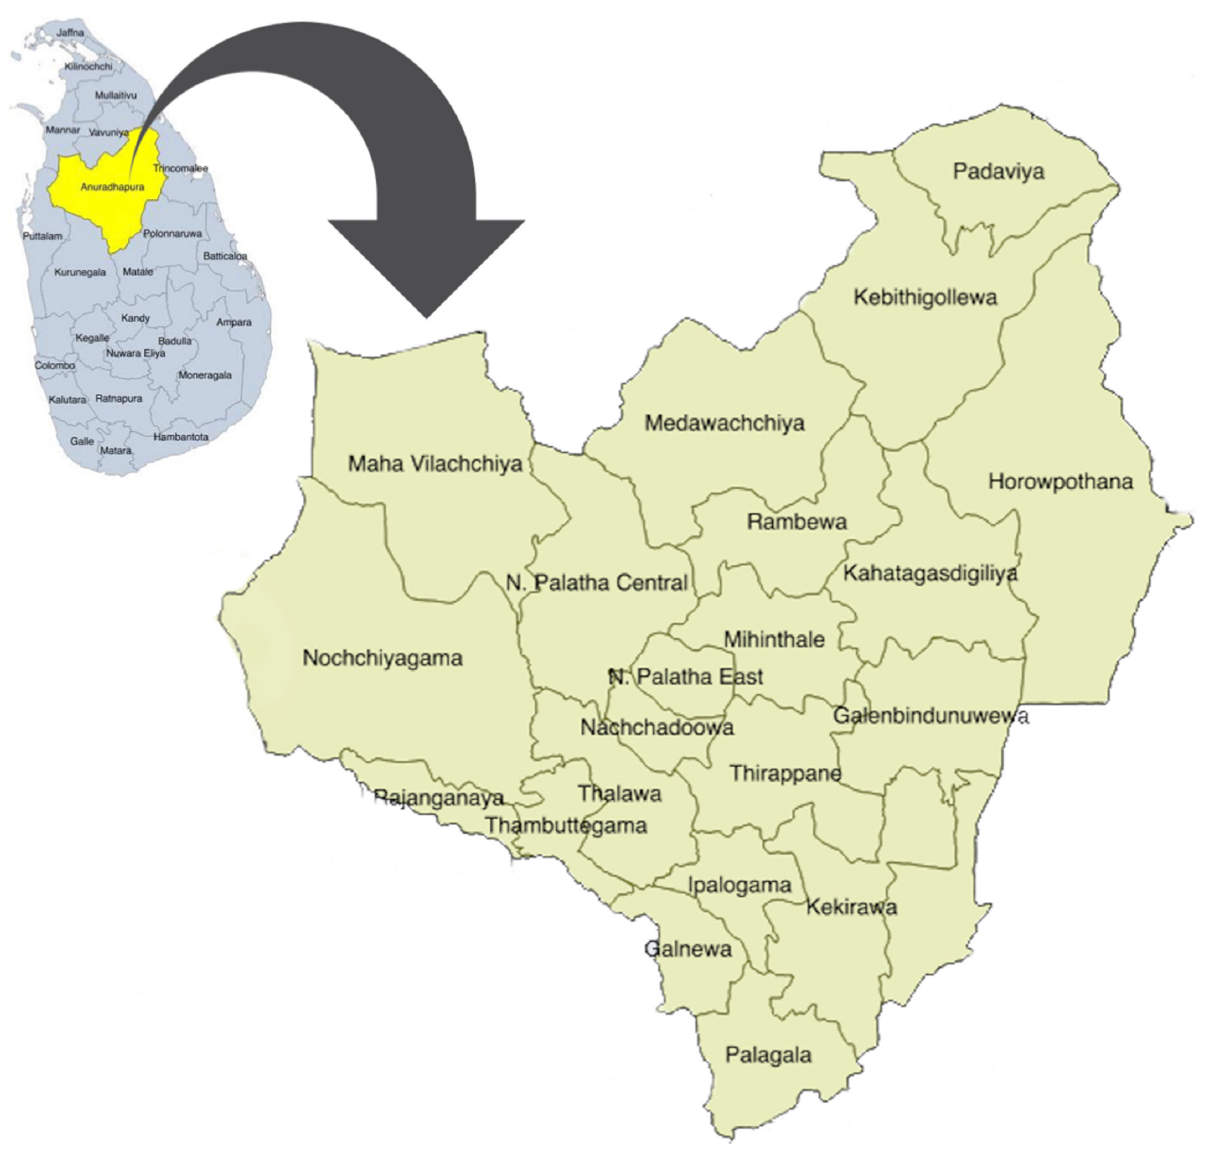
Figure 1. Map of the Anuradhapura district, Sri Lanka. This map depicts the position of Anuradhapura district (yellow) in the map of Sri Lanka (blue) and the area is enlarged to depict the 22 medical officer of health areas in the district. The figure has been reproduced